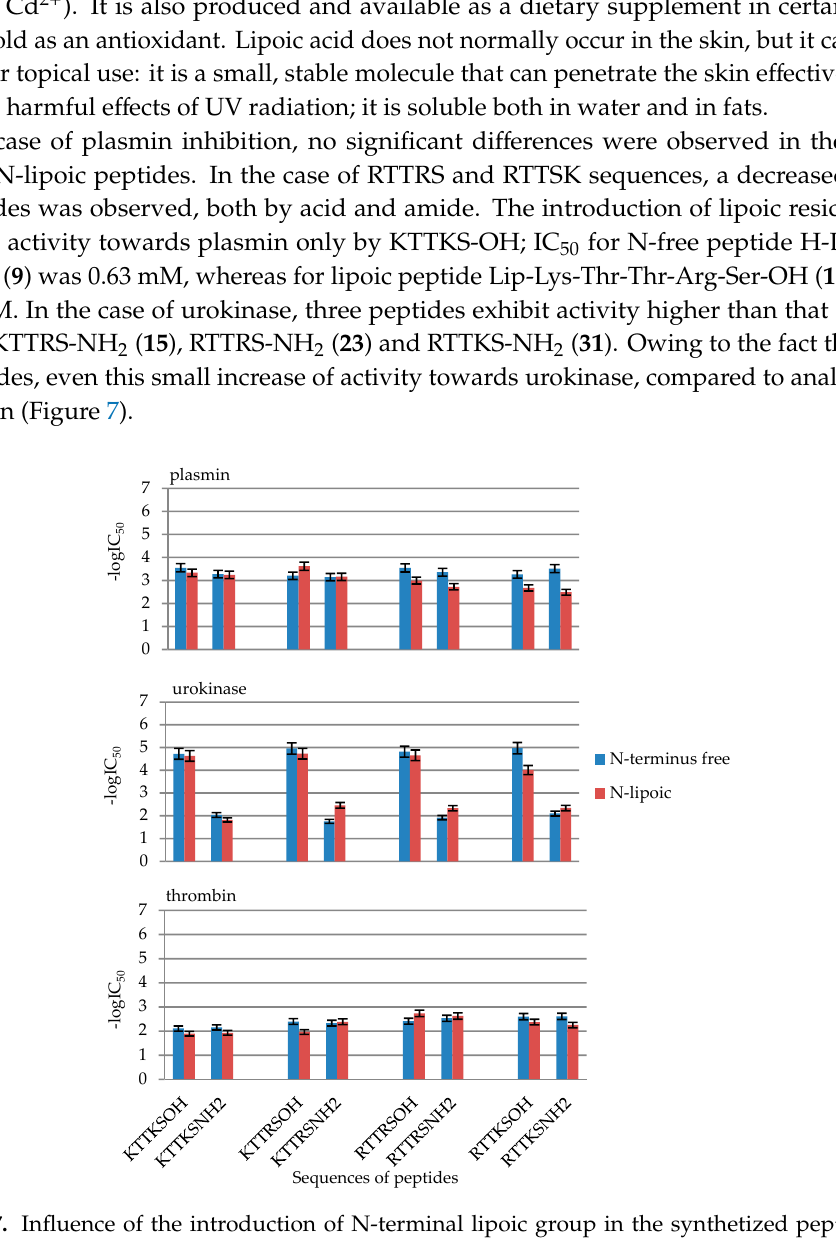
Figure 7. Influence of the introduction of N-terminal lipoic group in the synthetized peptides on plasmin, urokinase, thrombin inhibition. Inhibition values in the form of -logIC 50 from Table 2.